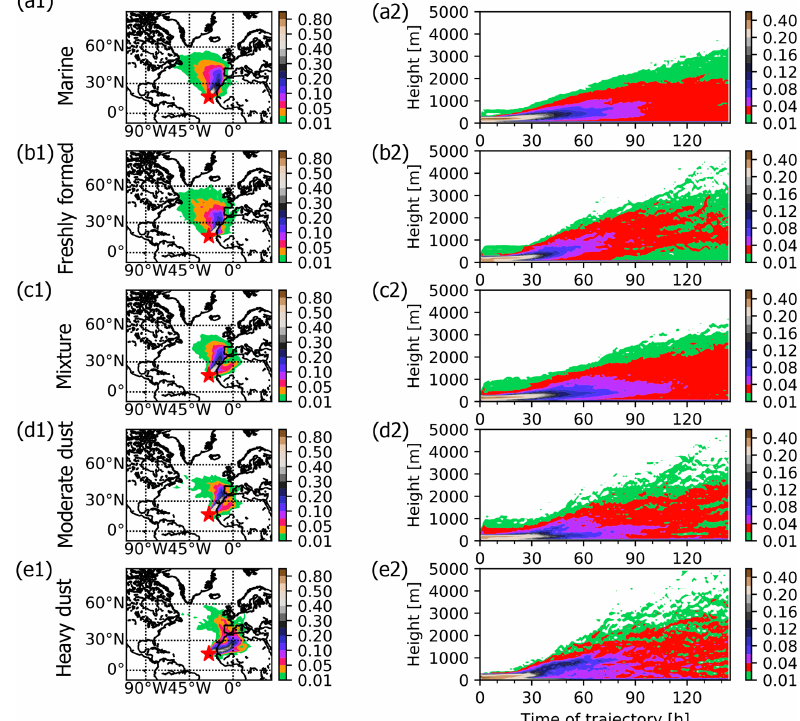
Figure 9. Relative frequencies of backward trajectory paths arriving at CVAO during marine (a1) , freshly formed (b1) , mixture (c1) , mod- erate (d1) and heavy dust (e1) periods and the corresponding relative frequency of backward trajectory height in panel (a2) to (e2)